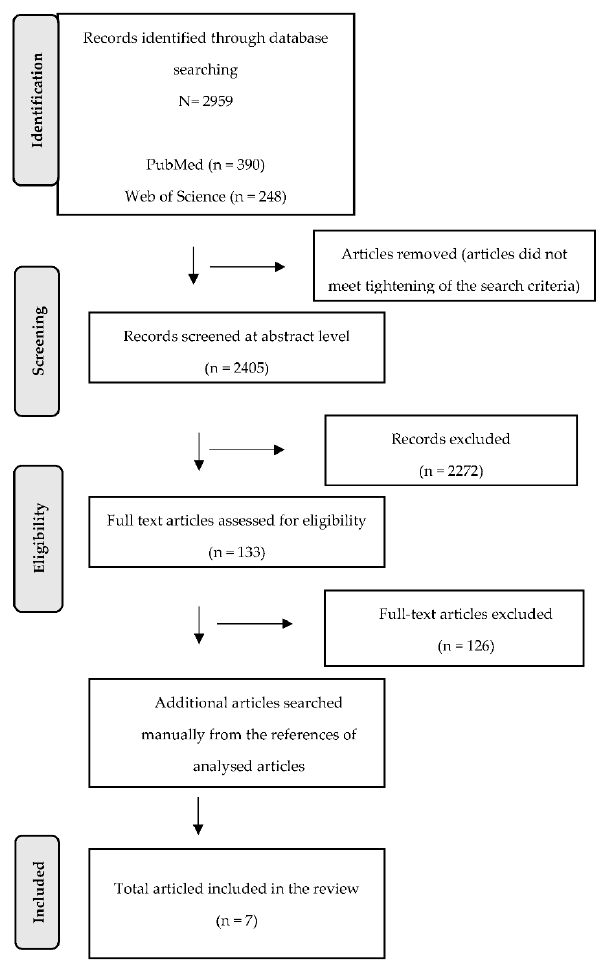
Figure 1. Flow diagram illustrating the selection process.